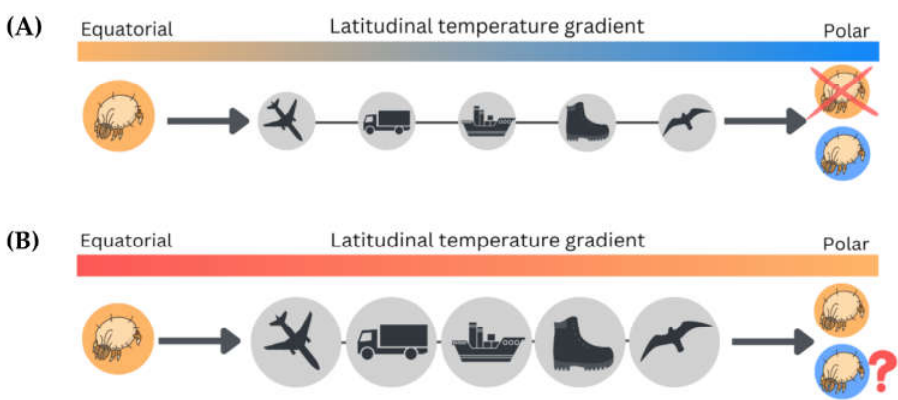
Figure 3. Depiction of possible arthropod distribution changes in response to warming temperatures associated with climate change. Blue circles represent native populations that prefer cold temperatures (i.e., polar regions) and orange circles represent non-native populations that prefer warm temperatures (i.e., non-polar regions). Grey circles represent different means of mediated dispersal, with size representing relative transport events to the poles (i.e., larger grey circles indicate higher propagule pressure). ( A ) Under a normal latitudinal temperature gradient with fewer introduction events, non-native species are unlikely to establish populations upon arrival to the poles due to mismatches between local environment (e.g., air temperature) and physiology; ( B ) Warmer temperatures and increased transport events may facilitate the establishment of non-native species at the poles by creating conditions within their optimal range, or facilitating rapid evolution in the new environment.